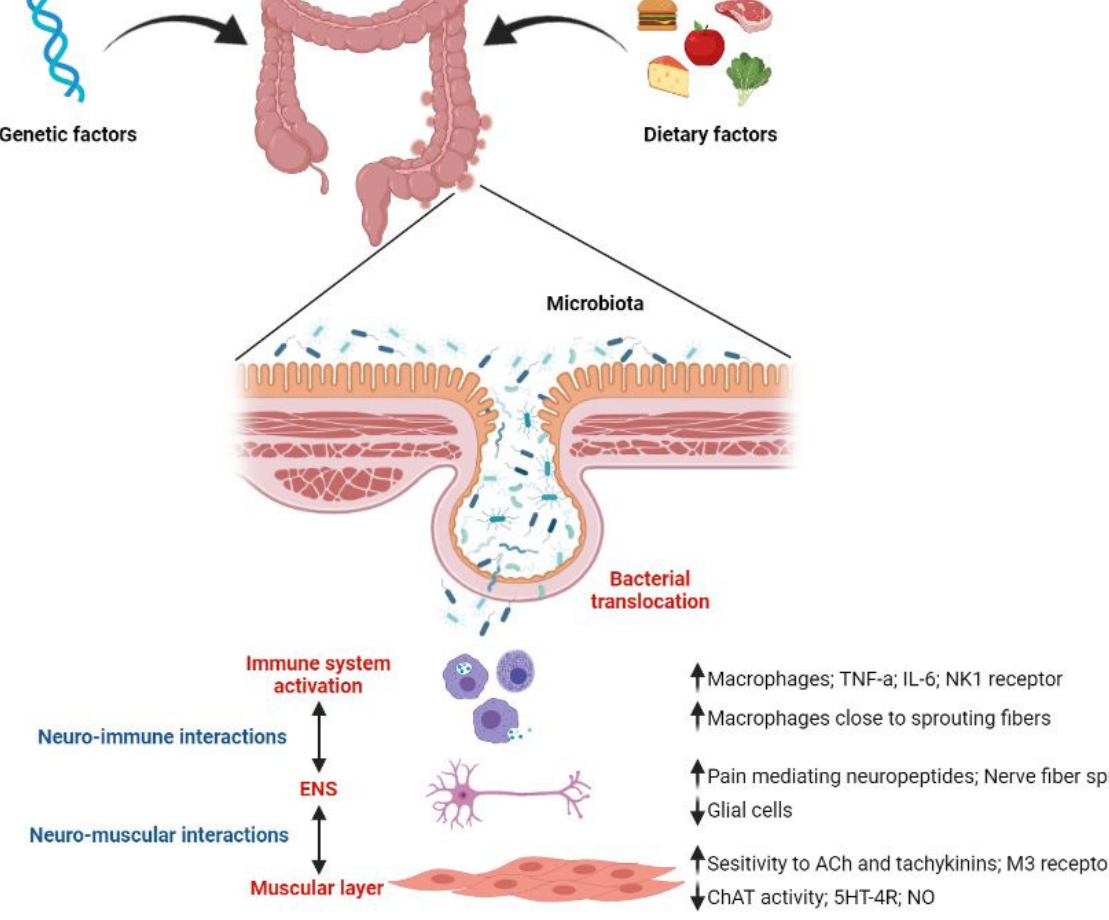
Figure 2. Representative figure of pathophysiological mechanisms involved in SUDD. ENS, enteric nervous system; Ach, acetylcholine; ChAT, choline acetyltransferase; NO, nitric oxide; TNF-a, tumor necrosis factor alpha; IL-6, interleukin-6; NK1, neurokinin1; 5HT-4R, 5idrossitriptamina-4 receptor; ↓ , decrease; ↑ , increase; ↕ , bidirectional interaction.